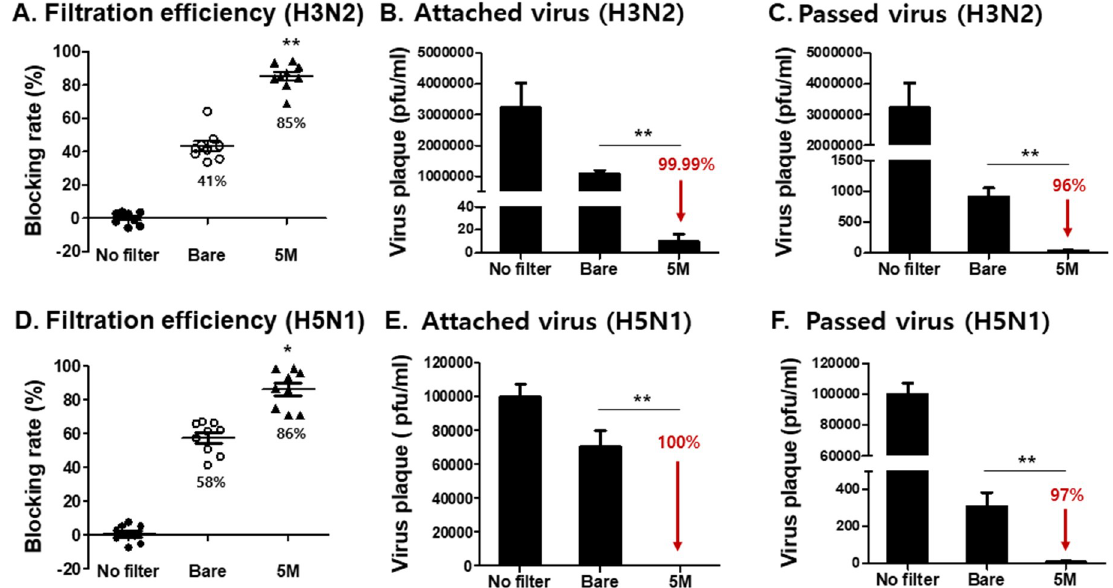
Fig 5. Efficacy of mask filters coated with salt against low amounts of viruses (A/H3N2, A/H5N1). Surgical mask filters were coated with 5M of salt and low amounts of aerosolized virus (A/H3N2, 2 mg/ml, 1.3x10 6 pfu, A/H5N1, 2 mg/ml, 4x10 4 pfu) were used. (A) Blocking efficiency of filter coated with 5M of salt against A/H3N2 virus (n = 9, mean ± SEM, �� P < 0.01), (B) Virus plaque titers of H3N2 virus captured on the mask filter (n = 5, mean ± SEM, �� P < 0.01), and (C) Virus titers of H3N2 virus passing through the mask filters (n = 5, mean ± SEM, �� P < 0.01). (D) Blocking efficiency of salt-coated mask filters against A/H5N1 virus (n = 9, mean ± SEM, � P < 0.05), and (E) Virus titers of H5N1 captured in the mask filter (n = 5, mean ± SEM, �� P < 0.01), (F) Virus titer of H5N1 passing through the mask filters (n = 5, mean ± SEM, �� P < 0.01).